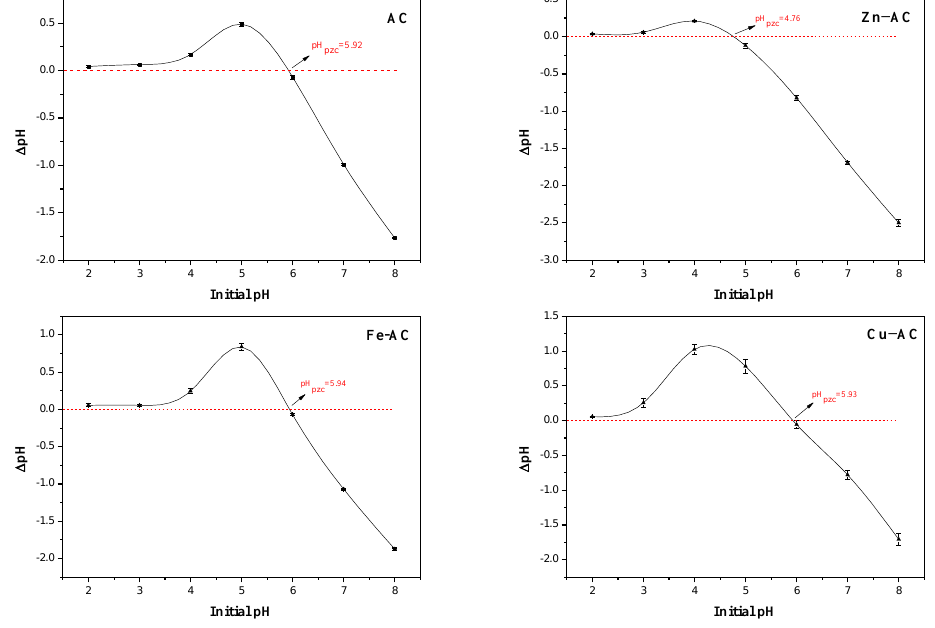
Figure 7. The pH PZC determination curves of the samples.